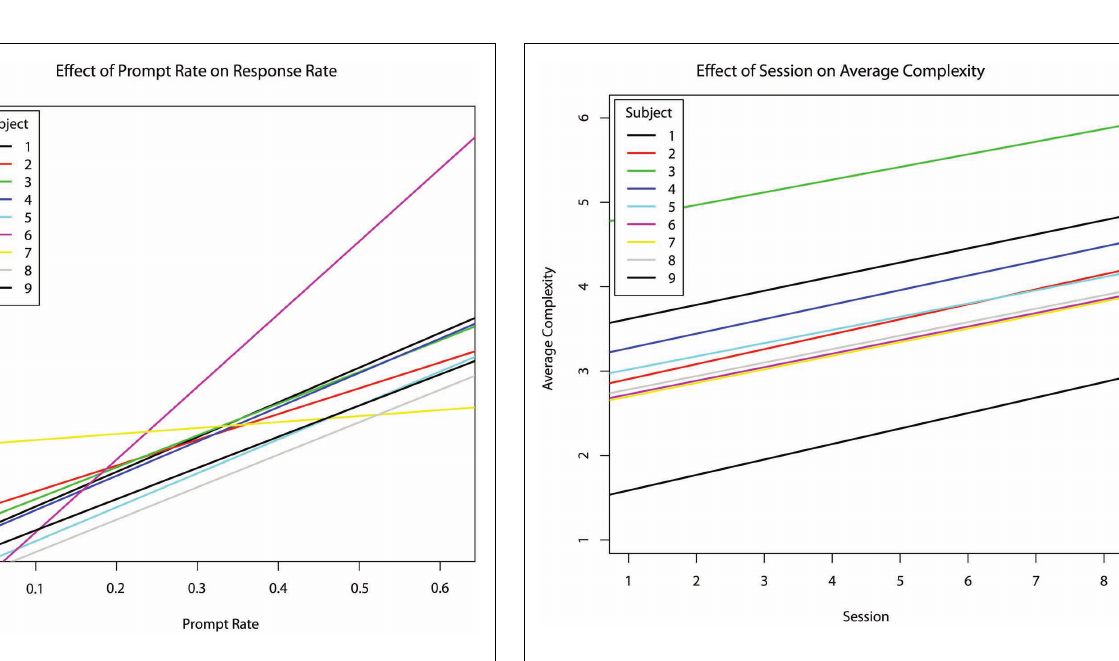
FIGURE 5 |The effect of chronological session on average choice complexity within each session, controlling for age. Choice complexity increased across sessions for every subject (with no decrement in response accuracy).